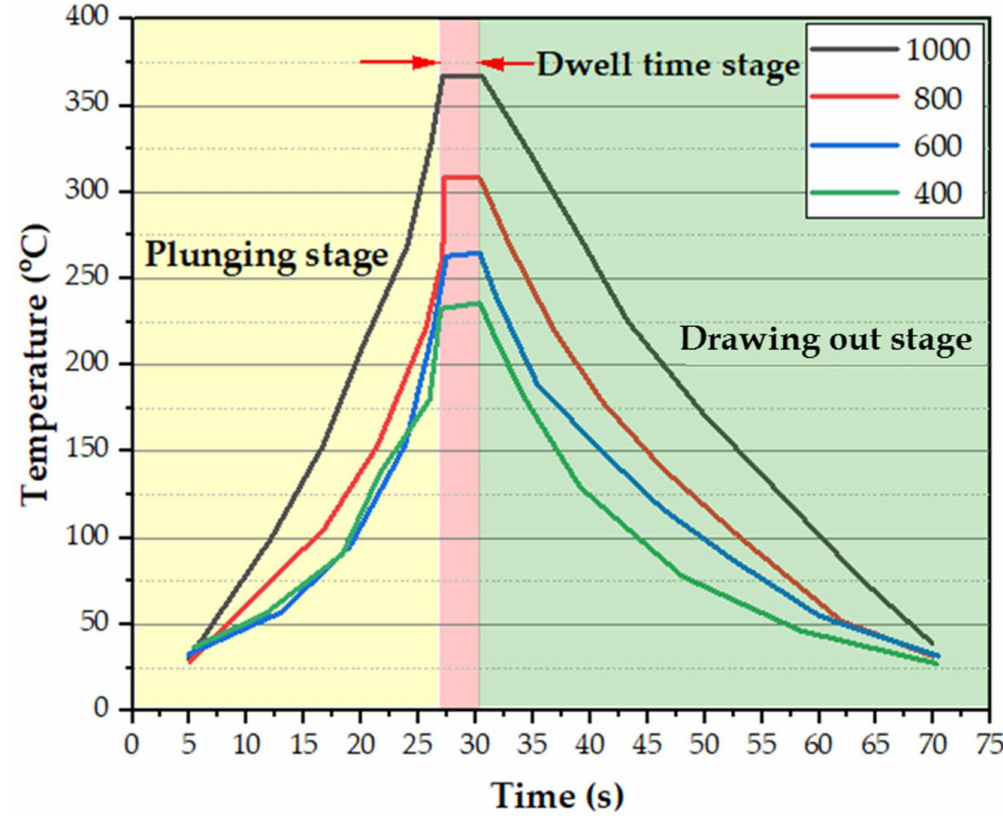
Figure 7. The thermal cycles during the FSSW of the dissimilar thin thickness AA6082-T6 lap joints processed at a constant dwell time of 3 s and the different rotational speeds of 400, 600, 800, and 1000